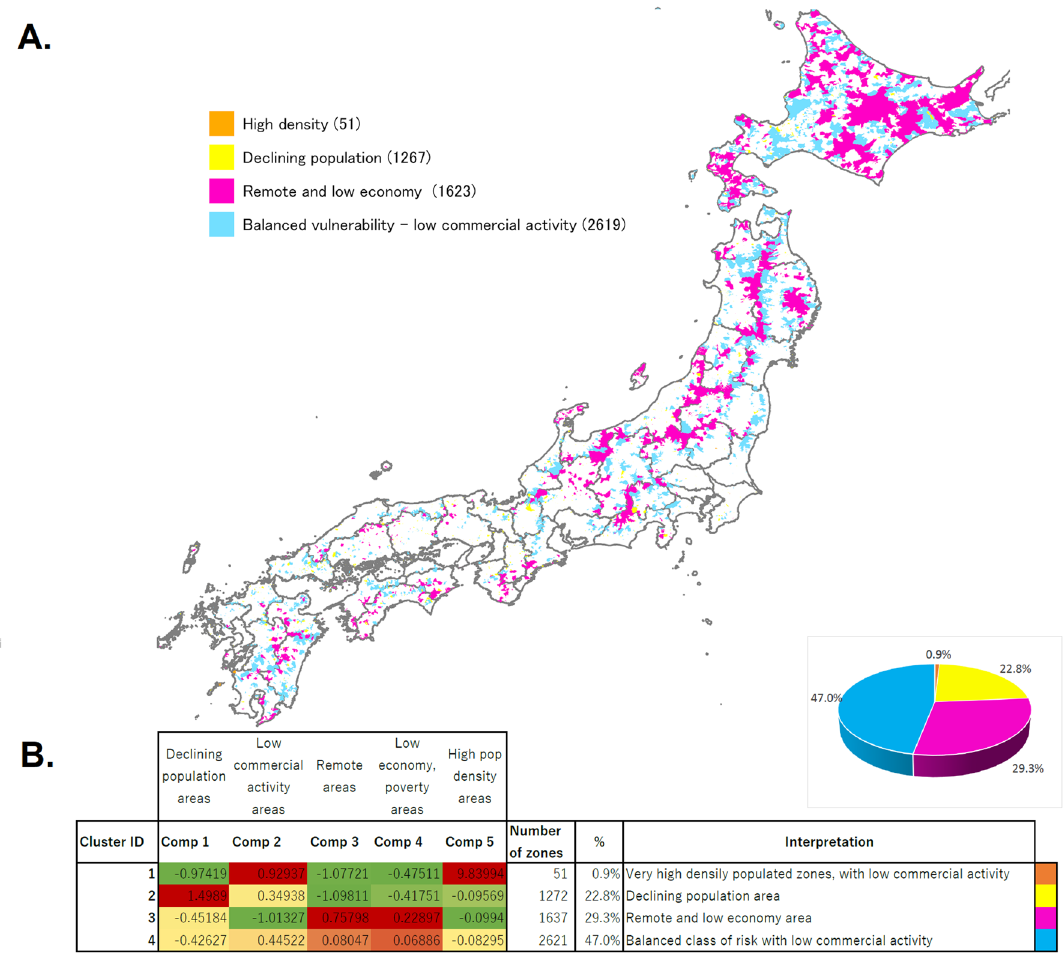
Figure 4. ( A ) Representation of the main patterns of high social vulnerability in Japan. ( B ) Result of clustering on high social vulnerability areas, with interpretation and distribution of the 4 clusters. Map generated using ArcGIS Pro